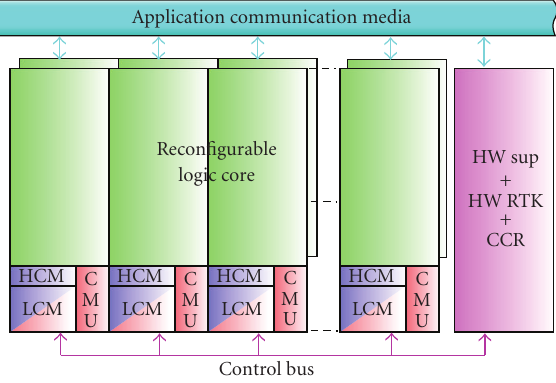
Figure 7: Global view of OLLAF